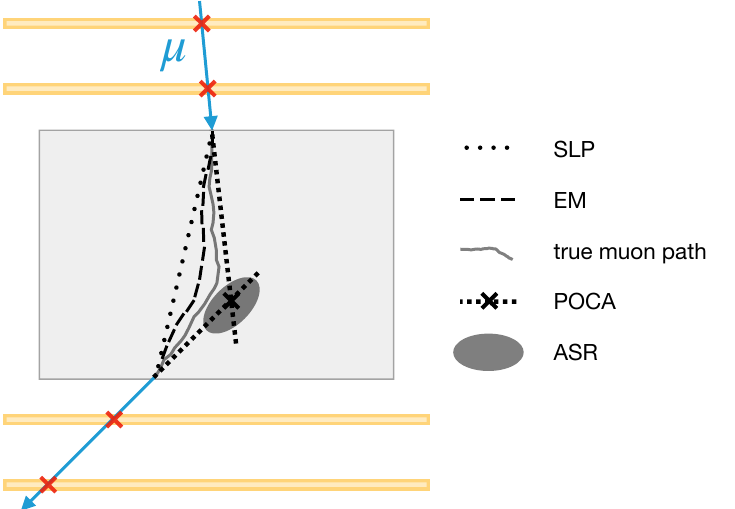
Figure 15. Illustration of popular muon scattering tomography reconstruction algorithms: Point of closest approach (POCA), straight line path (SLP), angle statistic reconstruction (ASR) and expectation maximisation